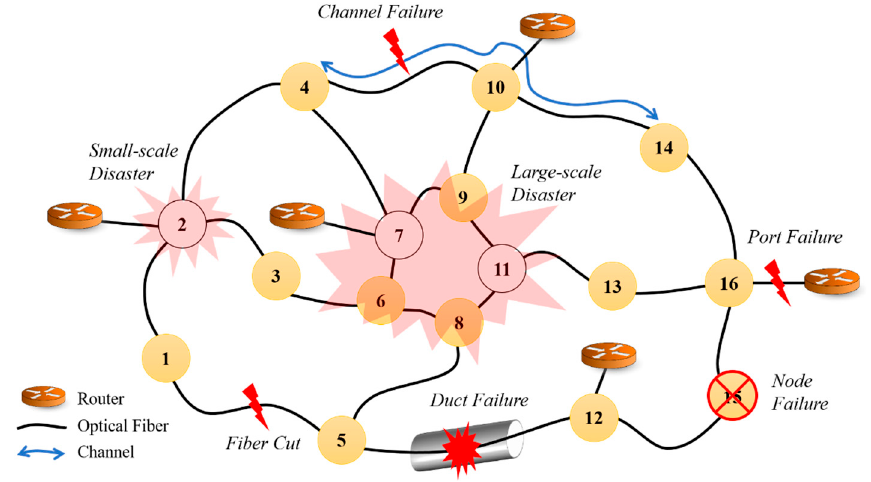
Figure 1. Types of Network Failures.